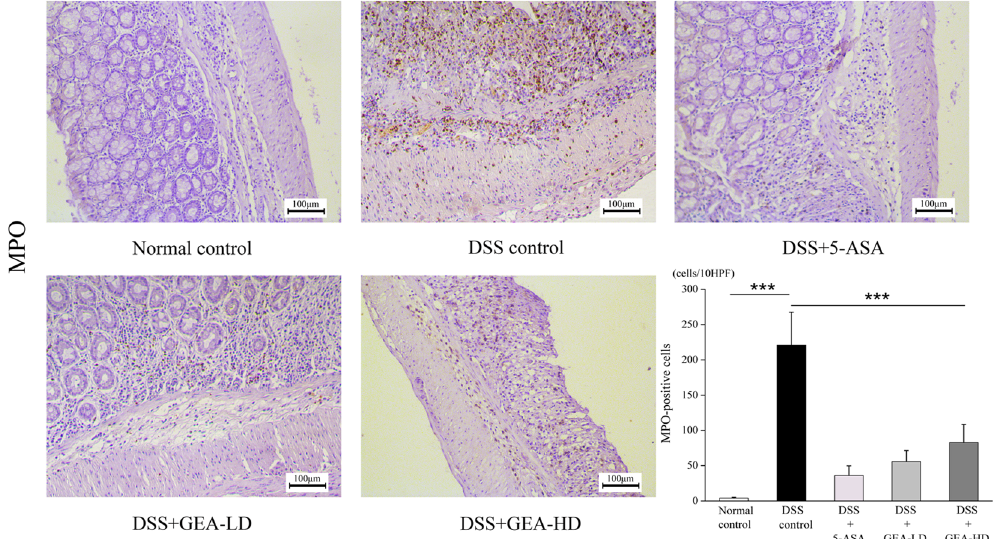
Figure 10. IHC for MPO showed that the numbers of accumulated neutrophils was significantly decreased in the GEA-LD and GEA-HD group compared with the DSS group. Scale bar = 100 μ m. The values are expressed as the mean ± S.D. * P < 0.05, ** P < 0.01, *** P <